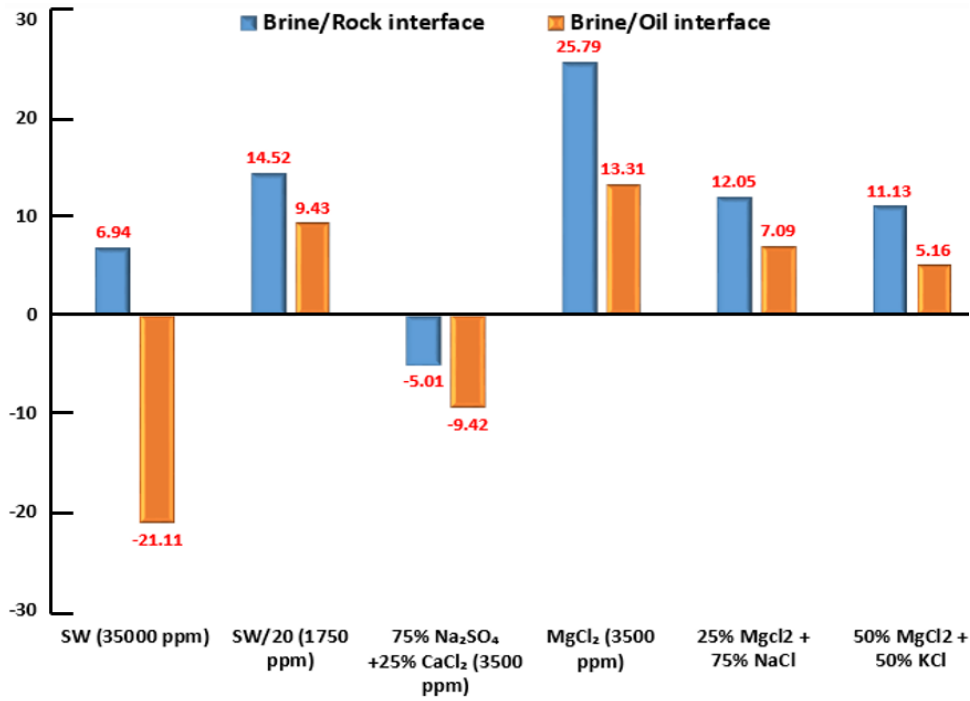
Figure 26. Zeta Potential (ZP) of brine/rock interface and brine/crude oil interface in different brine solutions at reservoir temperature of (80 ◦ C); SW (35000 ppm) and SW/20 denote seawater and 20-times diluted seawater respectively; all six brine solutions have a pH-value range between (6.45) and (7.80), as shown in Table